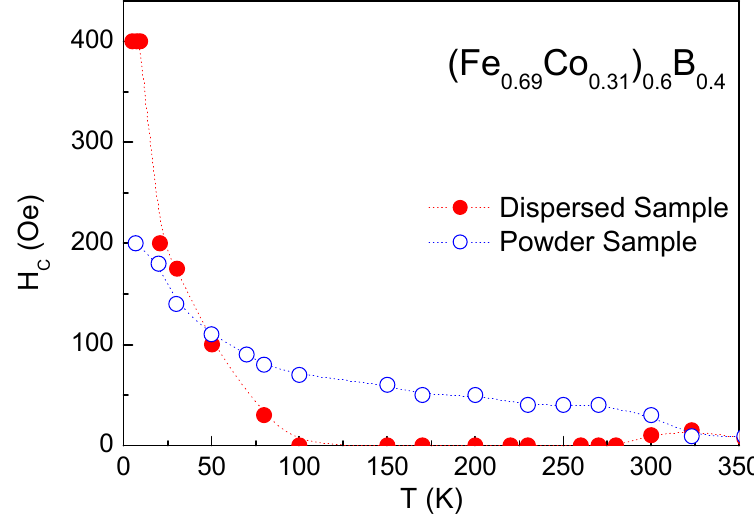
Figure 4. Coercive field vs. temperature for (Fe guide for the eye.